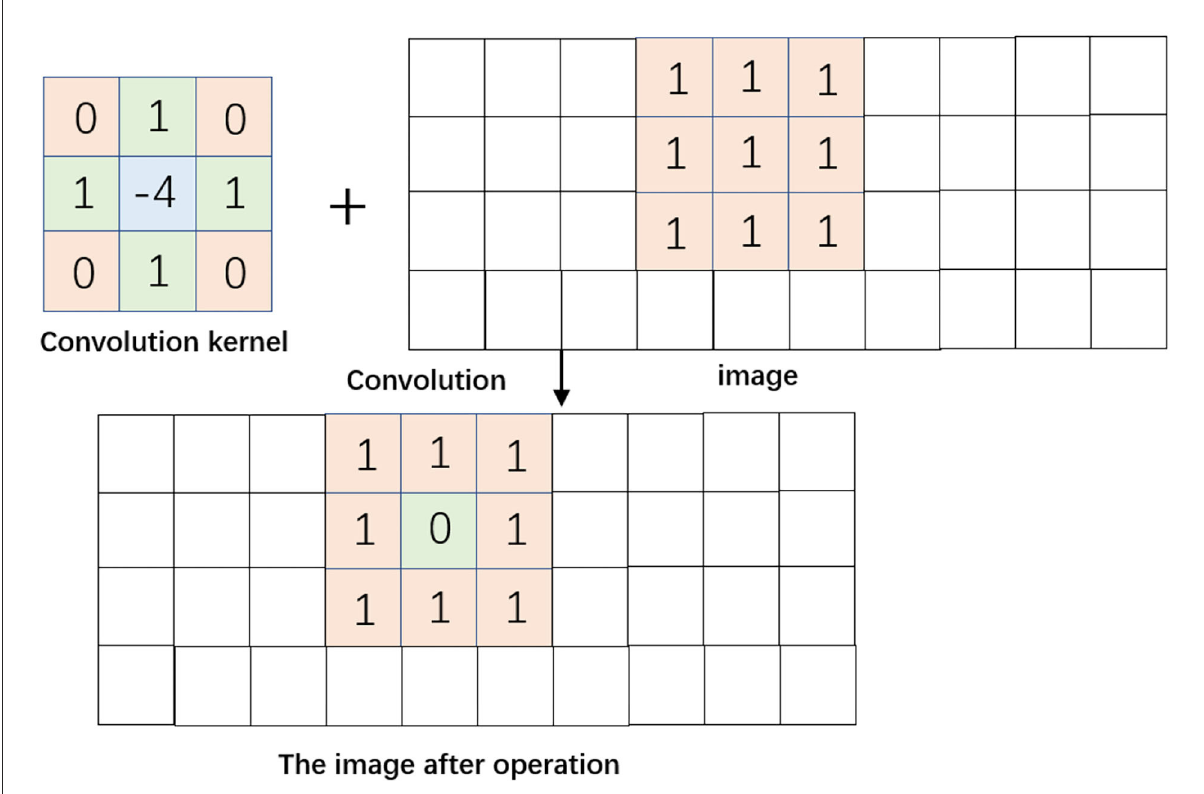
FIGURE3 Template and image convolution process.